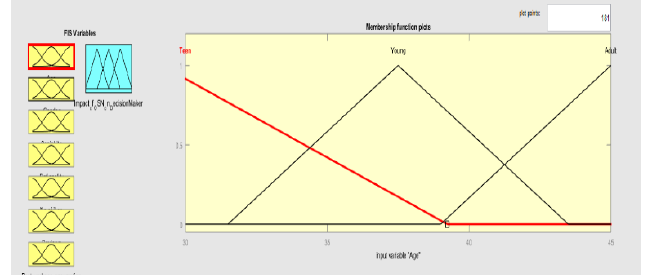
Figure 9. Membership functions defined